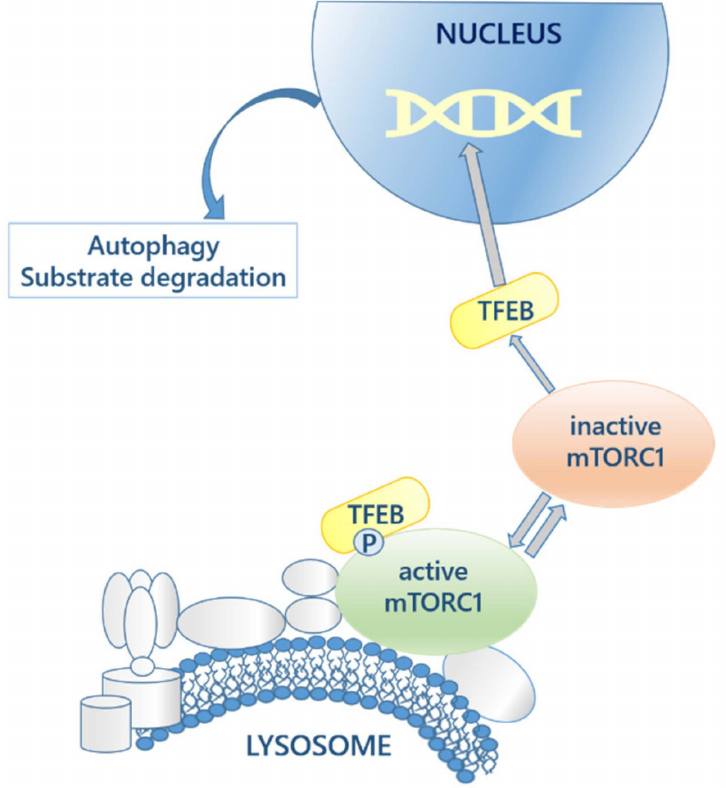
Figure 1. Autophagy activation route and lysosome-nuclei communication. The mTORC1 complex, attached to the lysosomal membrane, controls the activation of TFEB, which is translocated to the nucleus to activate the genes that regulate the autophagic